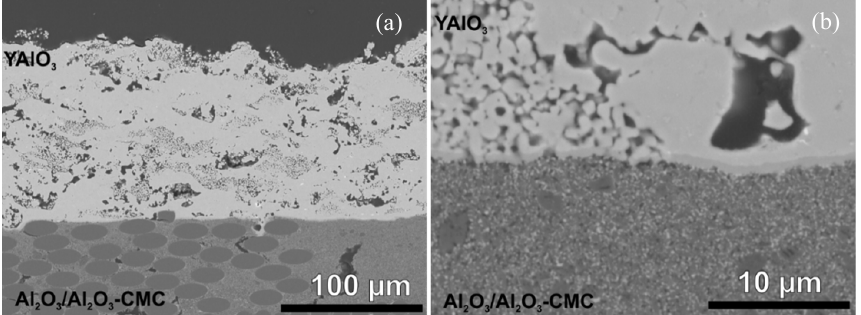
Figure 10. SEM images of cross sections of VLPPS YAlO 3 coatings after 1010 cycles of burner rig testing ( a ), close up of the coating substrate interface ( b ).